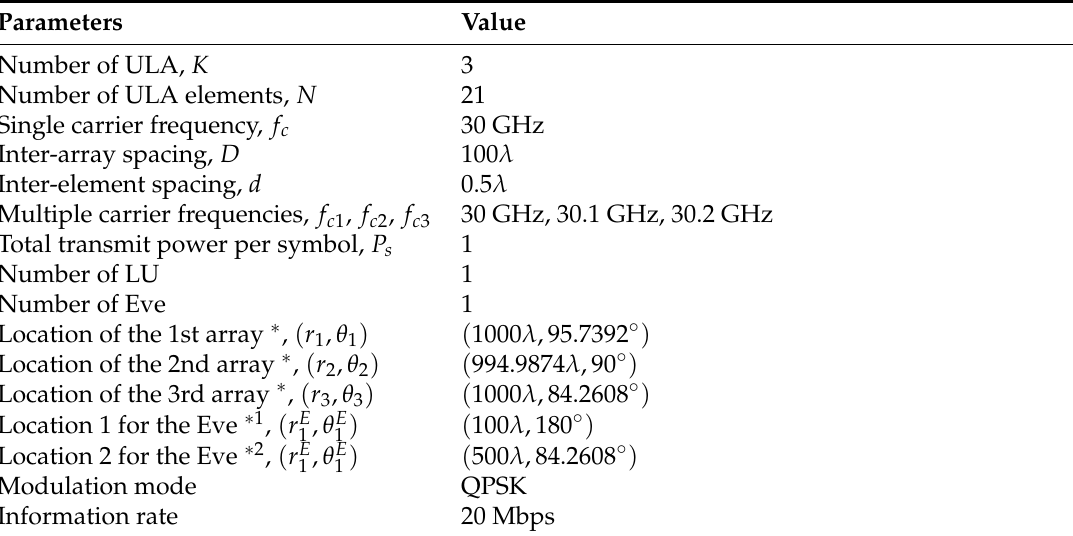
Table 2. Simulation